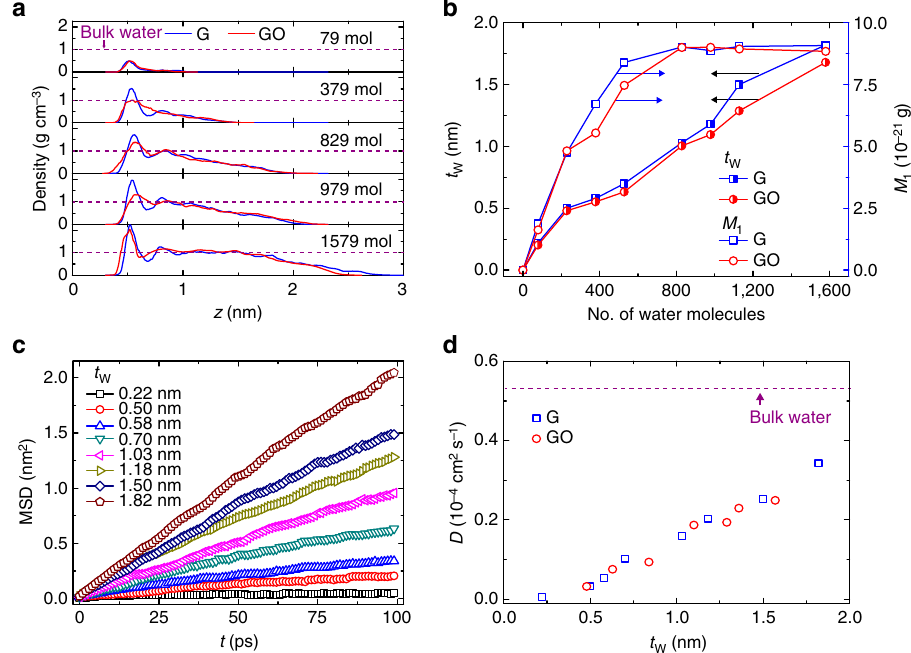
Figure 2 | Structural and dynamical properties of the intercalated water layers. ( a ) Mass density profiles of water molecules along the direction perpendicular to the interface, plotted for different numbers of intercalated water molecules. ( b ) The thickness of intercalated water layer t W and the water mass under the first peak ( M 1 ) in the density profiles, plotted as a function of the number of intercalated water molecules. The latter one represents the number of water molecules in the first nearest neighbours. M 1 is calculated as M 1 ¼ R z 1 A r ( z )d z , where r ( z ) is the mass density of water molecules, A is the z 0 area of interface, and z 0 and z 1 are the boundaries of the first peak in the density profiles. ( c , d ) The mean-square distance (MSD) and diffusion constant D measured for the intercalated water layer. D is compared with the diffusivity of bulk water calculated using the same water model 58 . NATURE COMMUNICATIONS|7:12854|DOI: